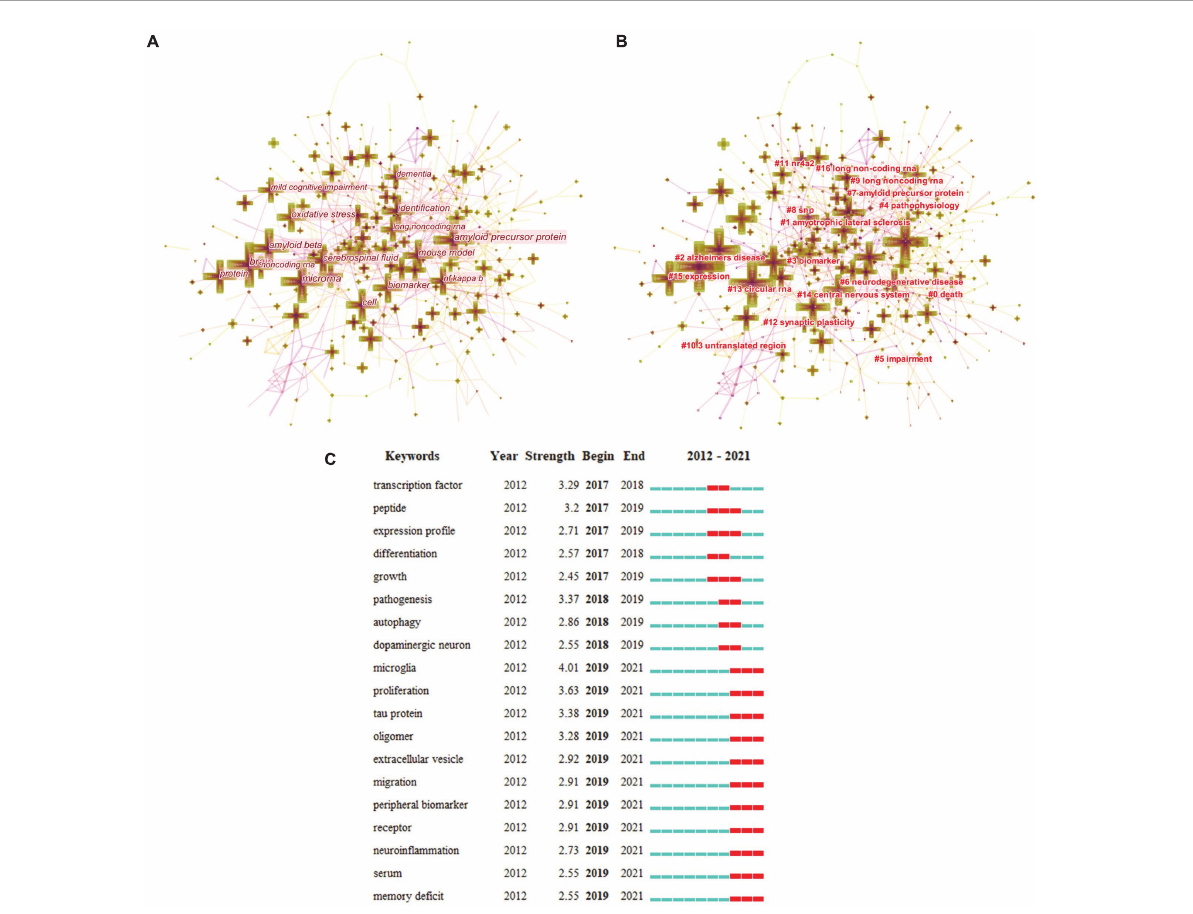
FIGURE5 The map of keywords co-occurrence (A) , keywords clusters (B) , and burst keywords (C) .